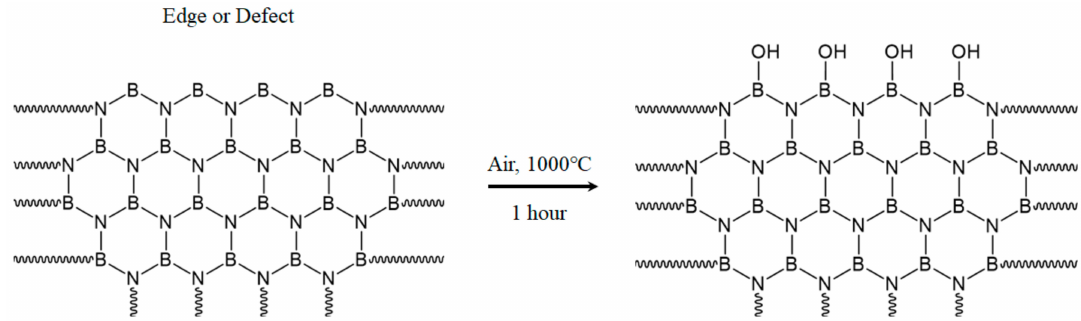
Figure 2. Schematic diagram of the surface treatment procedure of h-BN.